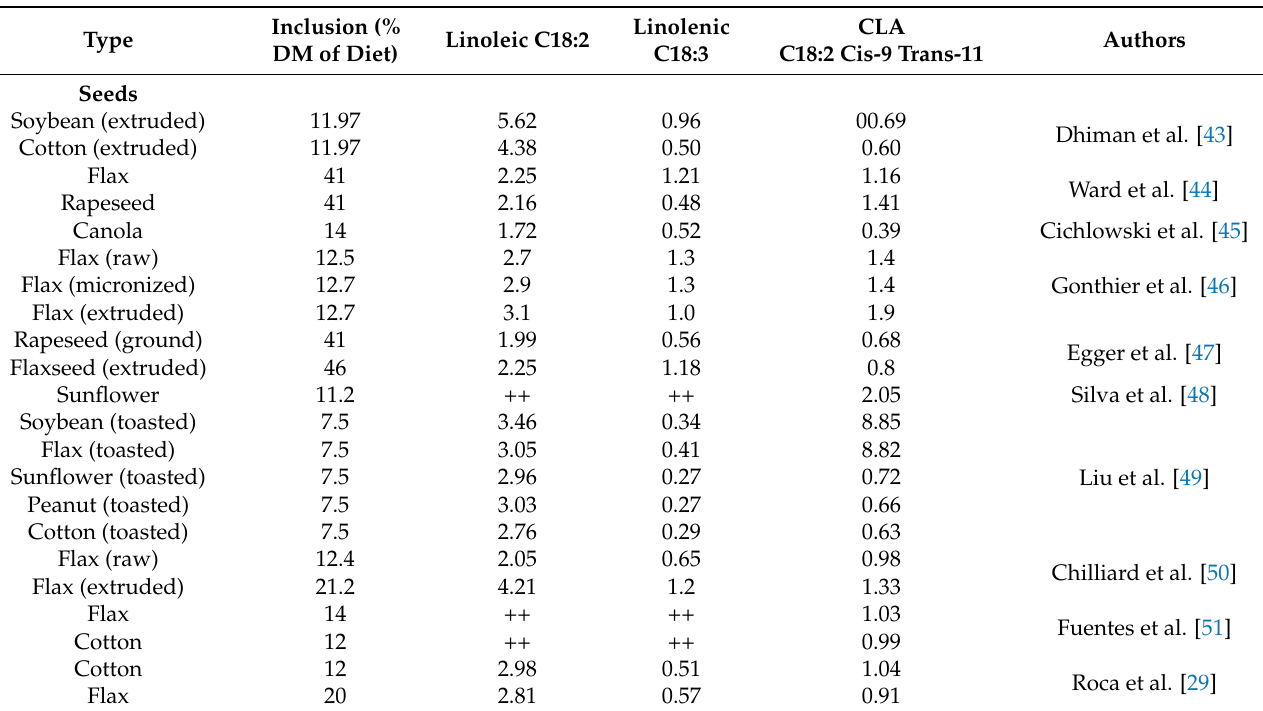
Table 1. Contents of linoleic C18:2, linolenic C18:3, and CLA FA in milk (g/100 g of fat) using different types of seeds in the feeding of dairy